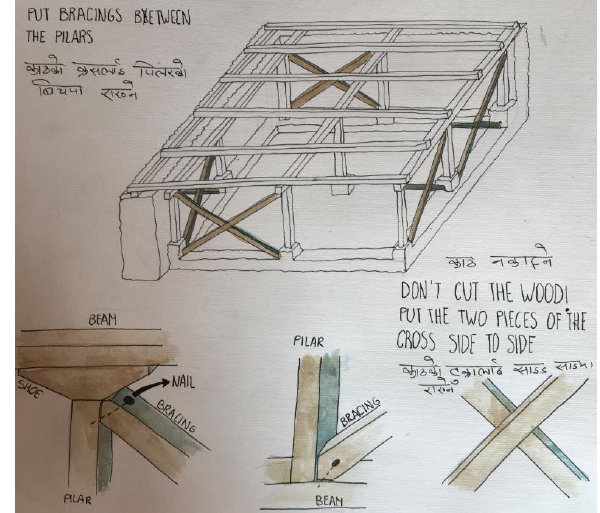
Figure 18. Bracings proposal (UEM Students).